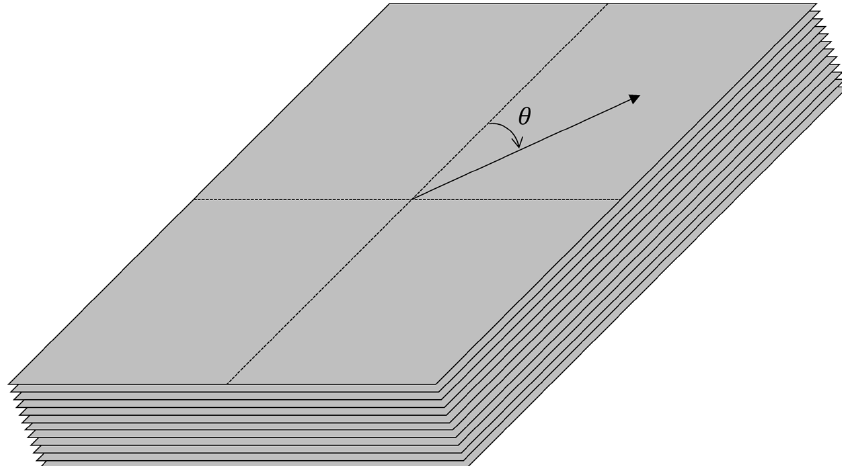
Figure 2. Configuration of 12 layers of UD CFRP specimen using pre-implemented composite fibers, USN 250A [25].